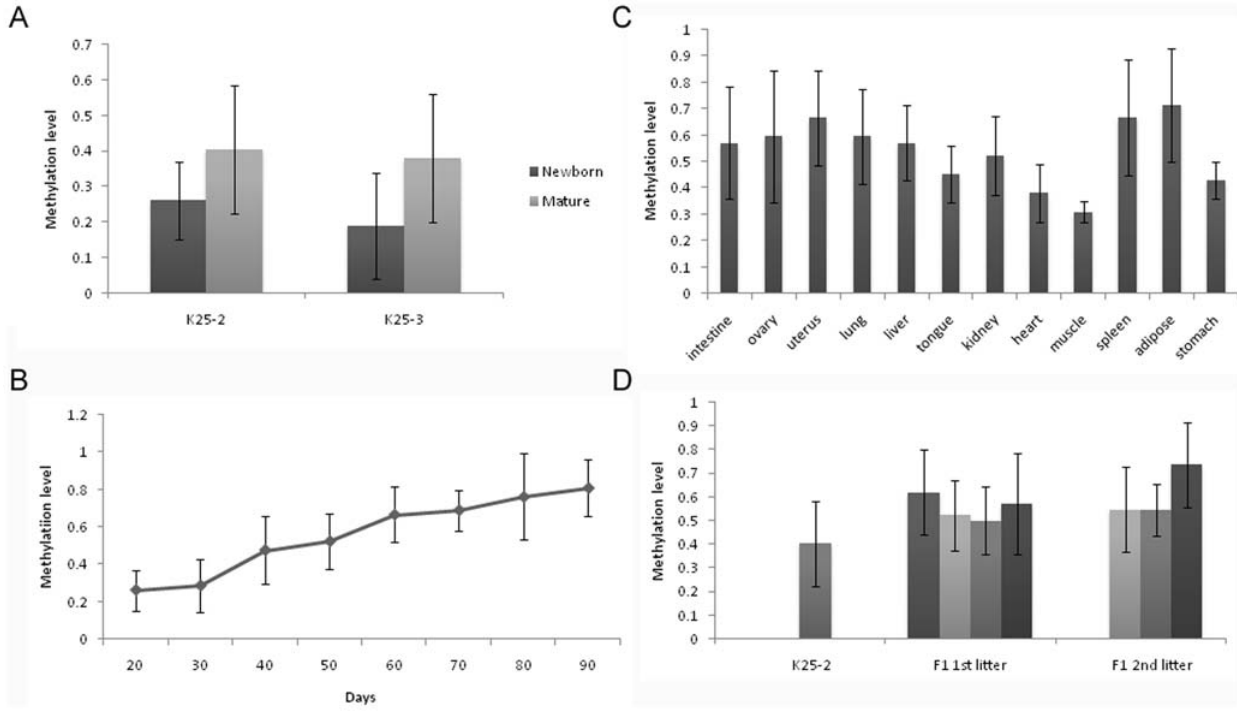
Figure 5. Methylation of CMV promoter. (A) Level of CMV methylation increased in founder transgenic pigs from newborn to maturity. The increases in CMV methylation level from 26% to 40% (p=1.000) and from 19% to 38% (p=0.799) were observed in K25-2 and K25-3, respectively; (B) Level of CMV methylation increased in transgenic fibroblast cells over time in culture. The increase in CMV methylation level from 20 to 90 days was more than 3-fold from 26% to 81% (p=0.053); (C) Variegation of CMV methylation in various tissues of transgenic pig. Hypermethylation and hypomethylation levels of CMV methylation were found in different tissues, but the difference was not significant (p=0.153); (D) Level of CMV methylation in offspring transgenic pigs. The increase in CMV methylation level from 40% to 58% on average of offspring was detected (p=0.537). Error bars denote standard deviations.